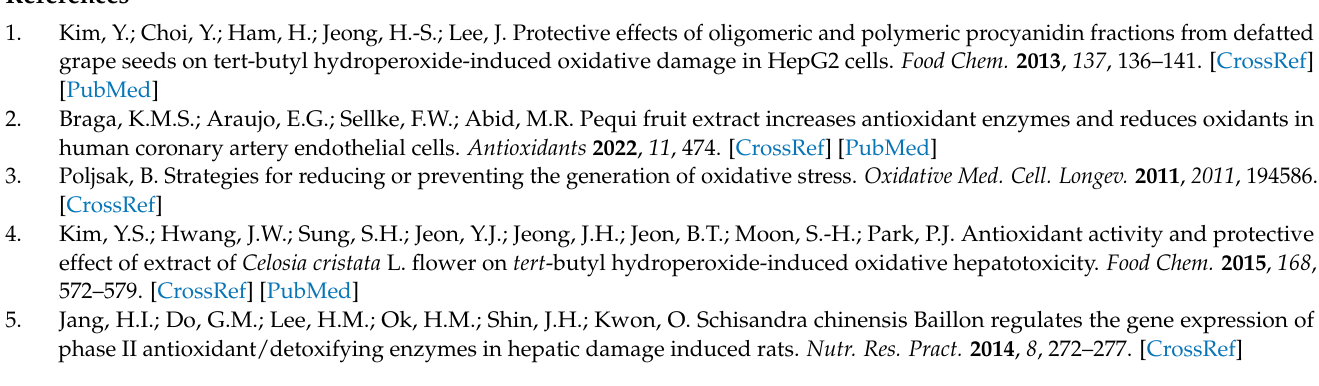
trum of yakuchinone A ( 3 ) (400 MHz, CDCl 3 ); Figure S8: 13 C-NMR spectrum of yakuchinone A ( 3 ) (100 MHz, CDCl 3 ); Figure S9: 1 H-NMR spectrum of 5 (cid:48) -hydroxyl-yakuchinone A ( 4 ) (400 MHz, CDCl 3 ); Figure S10: 1 H-NMR spectrum of 5 (cid:48) -hydroxyl-yakuchinone A ( 4 ) (300 MHz, CD 3 OD); Figure S11: 13 C-NMR spectrum of 5 (cid:48) -hydroxyl-yakuchinone A ( 4 ) (100 MHz, CDCl 3 ); Figure S12: 1 H- 1 H COSY spectrum of 5 (cid:48) -hydroxyl-yakuchinone A ( 4 ) (400 MHz, CDCl 3 ); Figure S13: HSQC spectrum of 5 (cid:48) -hydroxyl-yakuchinone A ( 4 ) (CDCl 3 ); Figure S14: HMBC spectrum of 5 (cid:48) -hydroxyl- yakuchinone A ( 4 ) (CDCl 3 ); Figure S15: DEPE-135 spectrum of 5 (cid:48) -hydroxyl-yakuchinone A ( 4 ) (CDCl 3 ); Figure S16: ESI-MS spectrum of 5 (cid:48) -hydroxyl-yakuchinone A ( 4 ); Figure S17: 1 H-NMR spec- trum of alpinenone ( 5 ) (500 MHz, CDCl 3 ); Figure S18: 13 C-NMR spectrum of alpinenone ( 5 ) (125 MHz, CDCl 3 ); Figure S19: 1 H-NMR spectrum of 6 α -hydroxy-7- epi - α -cyperone ( 6 ) (400 MHz, CD 3 OD); Figure S20: 13 C-NMR spectrum of 6 α -hydroxy-7- epi - α -cyperone ( 6 ) (100 MHz, CD 3 OD); Figure S21: 1 H-NMR spectrum of (4 S *,5 E ,10 R *)-7-oxo-tri- nor -eudesm-5-en-4 β -ol ( 7 ) (400 MHz, CDCl 3 ); Figure S22: 13 C-NMR spectrum of (4 S *,5 E ,10 R *)-7-oxo-tri- nor -eudesm-5-en-4 β -ol ( 7 ) (100 MHz, CDCl 3 ); Figure S23: 1 H-NMR spectrum of teuhetenone A ( 8 ) (400 MHz, CDCl 3 ); Figure S24: 13 C-NMR spec- trum of teuhetenone A ( 8 ) (100 MHz, CDCl 3 ); Figure S25: 1 H-NMR spectrum of 7- epi -teucrenone B ( 9 ) (400 MHz, CDCl 3 ); Figure S26: 13 C-NMR spectrum of 7- epi -teucrenone B ( 9 ) (100 MHz, CDCl 3 ); Figure S27: 1 H-NMR spectrum of 11-hydroxyvalenc-1(10)-en-2-one ( 10 ) (400 MHz, CDCl 3 ); Figure S28: 13 C-NMR spectrum of 11-hydroxyvalenc-1(10)-en-2-one ( 10 ) (100 MHz, CDCl 3 ); Figure S29: 1 H-NMR spectrum of oxyphyllenodiol A ( 11 ) (400 MHz, CDCl 3 ); Figure S30: 13 C-NMR spectrum of oxyphyllenodiol A ( 11 ) (100 MHz, CDCl 3 ); Figure S31: 1 H-NMR spectrum of oxyphyllen- odiol B ( 11 ) (400 MHz, CDCl 3 ); Figure S32: 13 C-NMR spectrum of oxyphyllenodiol B ( 11 ) (100 MHz, CDCl 3 ); Figure S33: HPLC chromatograms of crude extract and isolated compounds 1 – 12 ; Table S1: Partition coefficients of major peaks 1 and 2 of A. oxyphylla for CPC operation; Table S2: Retention time and calibration curves of compounds 1 – 12